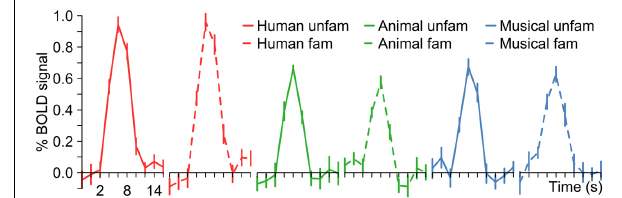
FIGURE 7 | BOLD signal time courses in the temporal lobes (combined left and right hemisphere) depending on stimulus category and the ability of the subjects to name the person, animal or instrument.